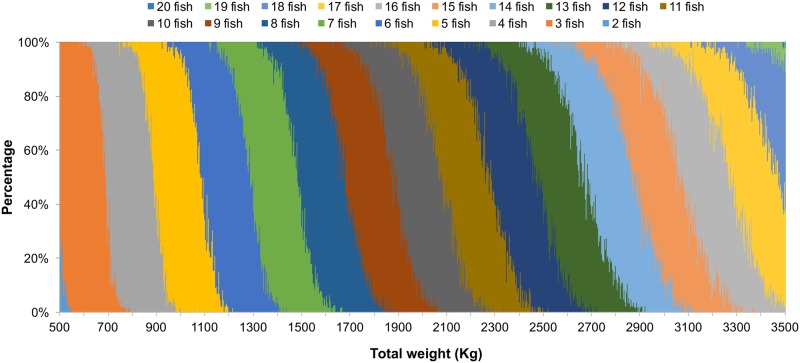
Simulated weight distribution by fish number.Each color band represents the weight distribution of a certain number of fish. For example, the left gray band shows the weight distribution of four fish, with a total weight of 650–950 kg.